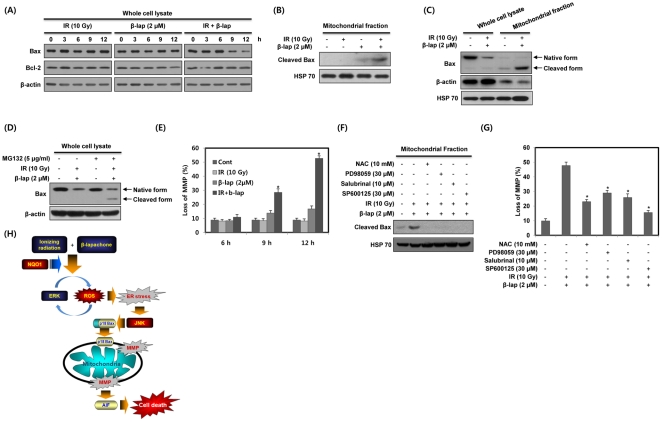
β-lap in combination with IR causes Bax cleavage and translocation of cleaved Bax to mitochondria.(A) NQO1+-MDA-MB-231 cells were treated with IR alone, β-lap alone or combination of IR and β-lap for the indicated times. Cell lysates were subjected to Western blot analysis. The data represent a typical experiment conducted three times with similar results. (B) NQO1+-MDA-MB-231 cells were treated with IR alone, β-lap alone or combination of IR and β-lap for 12 h. Mitochondrial fractions of NQO1+-MDA-MB-231 cells were prepared and subjected to Western blot analysis. The data are representative a typical experiment conducted three times. (C) NQO1+-MDA-MB-231 cells were treated with IR alone, β-lap alone or combination of IR and β-lap for 12 h. Whole cell lysates and mitochondrial fractions of NQO1+-MDA-MB-231 cells were prepared and subjected to Western blot analysis. The data are representative a typical experiment conducted three times. (D) NQO1+-MDA-MB-231 cells were treated with combination of IR and β-lap for 24 h in the presence or absence of MG132. The data are representative a typical experiment conducted three times. (E) NQO1+-MDA-MB-231 cells were treated with IR alone, β-lap alone or combination of IR and β-lap for the indicated times. After 12 h, the concentration of retained DiOC6(3) in cells was measured by flow cytometry. Results from three independent experiments are expressed as means ± SEMs. (F) NQO1+-MDA-MB-231 cells were treated with combination of IR and β-lap for 12 h in the presence or absence of NAC, PD98059, Sal or SP600125. Mitochondrial fractions were prepared and subjected to Western blot analysis. The data are representative a typical experiment conducted three times. (G) NQO1+-MDA-MB-231 cells were treated with combination of IR and β-lap for 12 h in the presence or absence of NAC, PD98059, Sal or SP600125. After 12 h, the concentration of retained DiOC6(3) in cells was measured by flow cytometry. Results from three independent experiments are expressed as means ± SEMs. (H) Schematic model of combined treatment (IR+β-lap)-induced apoptotic cell death. Combined treatment with IR and β-lap increases mitochondrial apoptotic cell death in an NQO1 dependent manner. As described in detail in the text, positive feedback regulation between ERK and ROS induced by combined treatment plays a critical role in the induction of ER stress. This enhanced ER stress is required for JNK activation, which leads to subsequent mitochondrial apoptotic cell death. Moreover, JNK activation induces cleavage of Bax and mitochondrial translocation of cleaved Bax, which causes loss of mitochondrial transmembrane potential and consequent release of AIF.